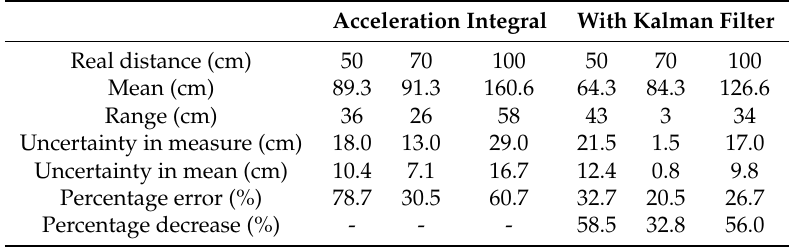
Table 5. Displacement in the space measured with the Waspmote.